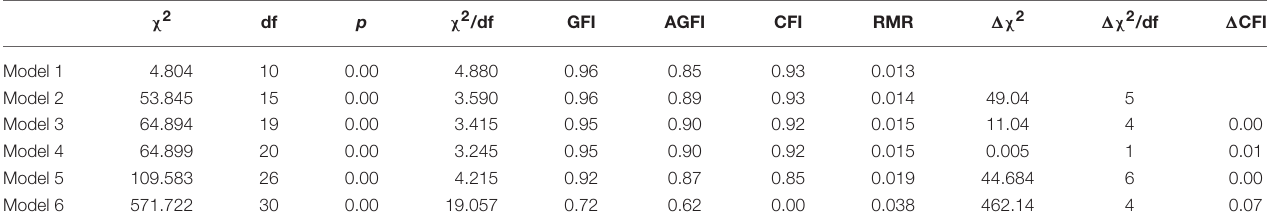
TABLE 4 | Comparative indexes for second model (dimension parental negative control).